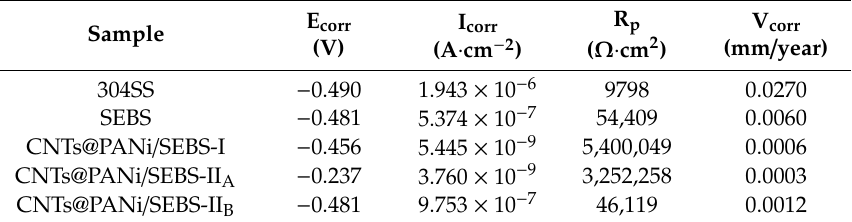
Table 2. Tafel polarization parameters of CNTs@PANi / SEBS composite